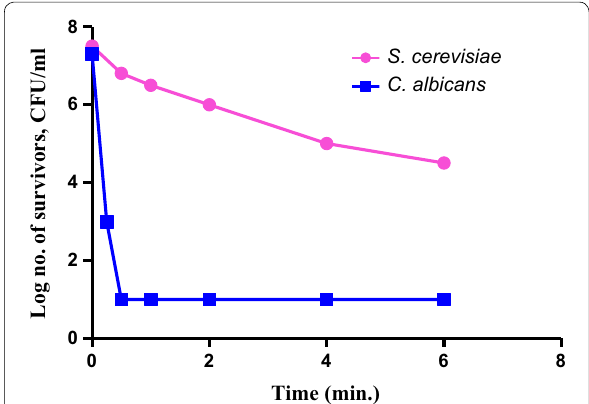
Fig. 6 Biocidal dynamics of OV EO (1% v/v) against two yeast